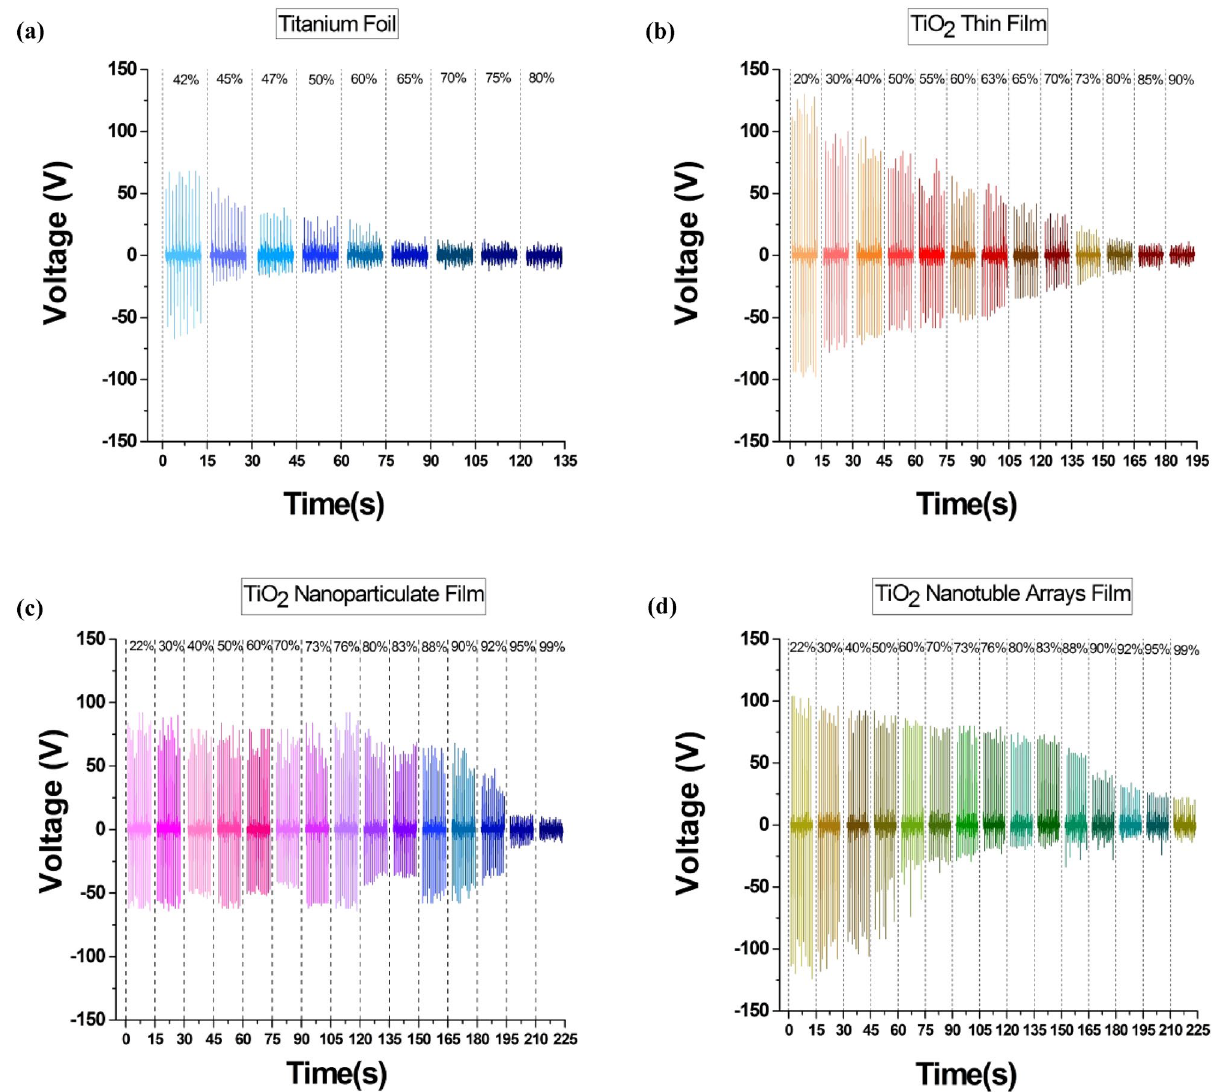
( d ) TiO 2 nanotube